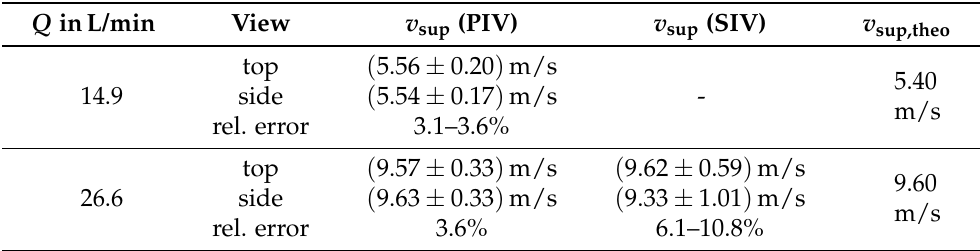
Table 3. Calculated and theoretical free jet velocities with standard deviations for PIV and SIV measurements of the MWF free